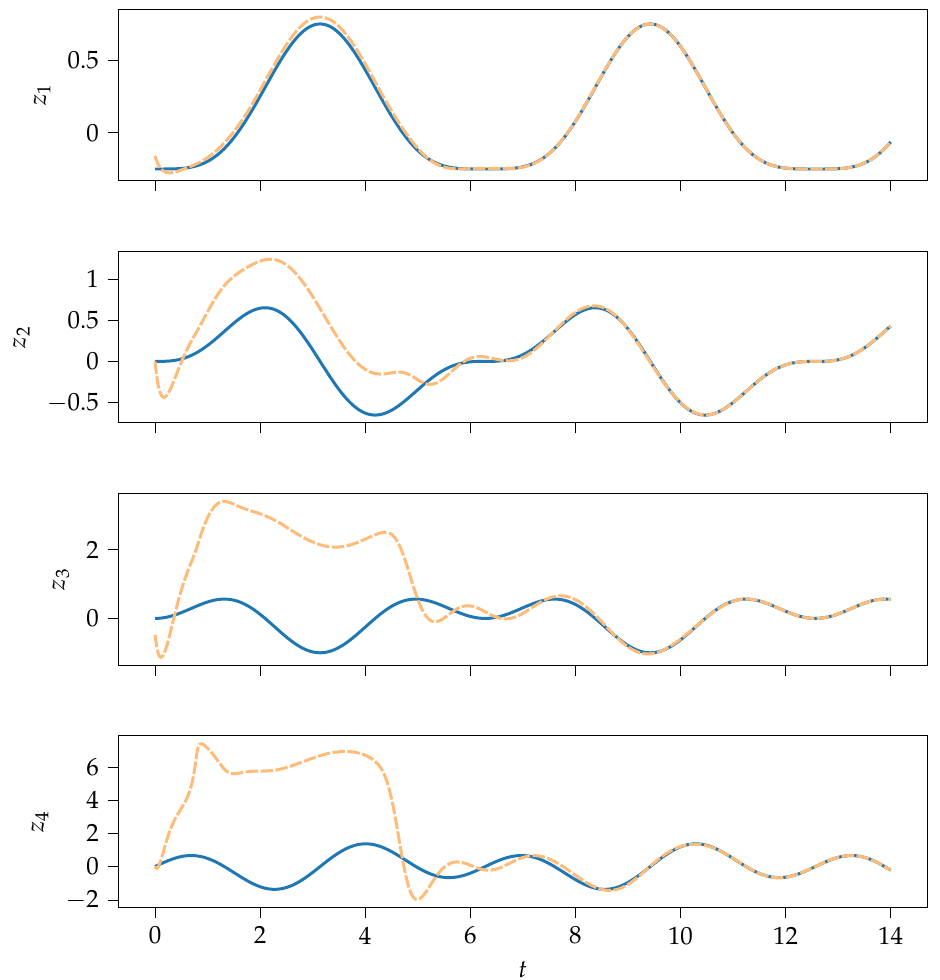
Figure 5. Trajectories for the embedded system state z (blue/dark/solid) and the observer state ˆ z (orange/light/dashed) of the system (15).